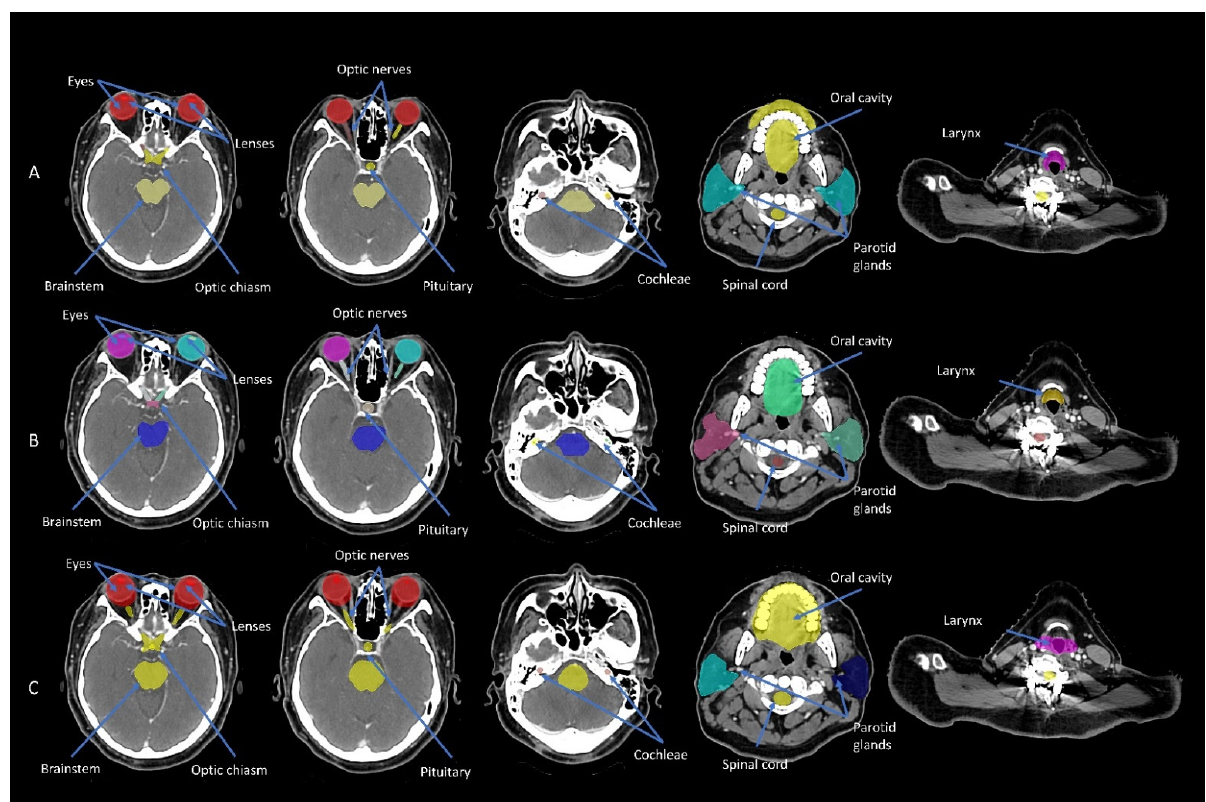
Figure 3. Organs at risk segmentation for a 75-year-old man with T3N2M0 nasopharyngeal cancer by manual contouring ( A ), DL ( B ) and atlas-based auto-contouring ( C ) with the following Dice similarity coefficient, Hausdorff distance, and 95th-percentile of Hausdorff distance values for brainstem (0.81, 7.20 mm and 4.39 mm vs. 0.83, 7.13 mm and 4.11 mm), left (L) cochlea (0.45, 5.24 mm and 2.92 mm vs. 0.81, 1.17 mm and 1.17 mm), right (R) cochlea (0.42, 6.83 mm and 3.53 mm vs. 0.79, 2.32 mm, 1.17 mm), L eye (0.85, 4.00 mm and 3.30 mm vs. 0.89, 3.30 mm, 2.33 mm), R eye (0.87, 3.52 mm and 2.33 mm vs. 0.88, 6.00 mm and 3.54 mm), larynx (0.47, 24.82 mm and 13.87 mm vs. 0.28, 18.89 mm and 12.51 mm), L lens (0.77, 2.32 mm and 1.41 mm vs. 0.53, 3.30 mm and 2.46 mm), R lens (0.67, 2.32 mm and 1.41 mm vs. 0.56, 3.30 mm and 2.46 mm), optic chiasm (0.47, 7.86 mm and 5.25 mm vs. 0.44, 9.61 mm and 4.42 mm), L optic nerve (0.66, 7.77 mm and 3.91 mm vs. 0.62, 4.33 mm and 3.31 mm), R optic nerve (0.70, 4.64 mm and 2.70 mm vs. 0.46, 8.45 mm and 3.93 mm), oral cavity (0.84, 19.31 mm and 10.24 mm vs. 0.68, 16.57 mm and 11.12 mm), L parotid gland (0.83, 11.71 mm and 4.78 mm vs. 0.57, 19.18 mm and 9.34 mm), R parotid gland (0.81, 10.73 mm and 4.74 mm vs. 0.69, 17.25 mm and 7.38 mm), pituitary (0.51, 3.71 mm and 2.54 mm vs. 0.46, 5.32 mm and 3.49 mm) and spinal cord (0.52, 220.13 mm and 104.18 mm vs. 0.79, 34.90 mm and 12.26 mm),